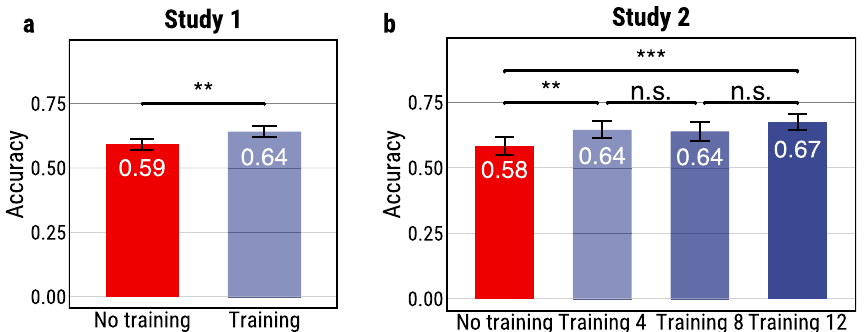
Figure 5. (a) Results of Study 1. Comparison between the prediction accuracy of participants in the two conditions: no training (control) vs. training (treatment). Trained participants, who were shown four labeled photos, perform significantly better than untrained participants. (b) Results of Study 2. Comparison between the prediction accuracy of participants who were not shown any training photos and participants who were shown 4, 8, or 12 training photos. As in Study 1, showing participants four labeled photos significantly improves their prediction accuracy. However, the improvements of showing additional labeled photos are not statistically significant. (The error bars represent 95% confidence intervals; *** p < 0.001 , ** p < 0.01 , * p < 0.05